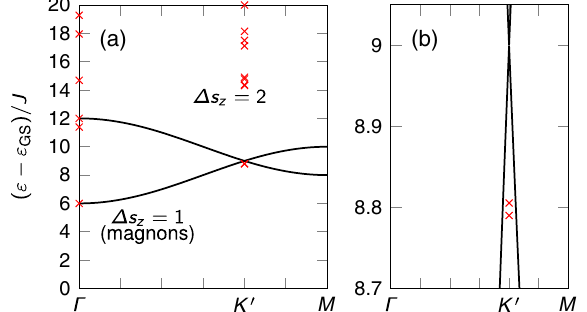
FIG. 20. Spectrum of the chiral magnet obtained from exact diagonalization for S ¼ 1 . Energies are given with respect to the ground-state energy ε . (a) Momentum dependence of the GS spectrum for D=J ¼ 0 . 15 at B=J ¼ 6 , causing an energetic 1 excitations (magnons) and higher- separation between Δ s z ¼ spin excitations. Black lines indicate the spin-wave spectrum given in Eq. (12). (b) Zoom into the relevant energy window of Dirac magnons, which are clearly gapped. A cluster of 18 spins was